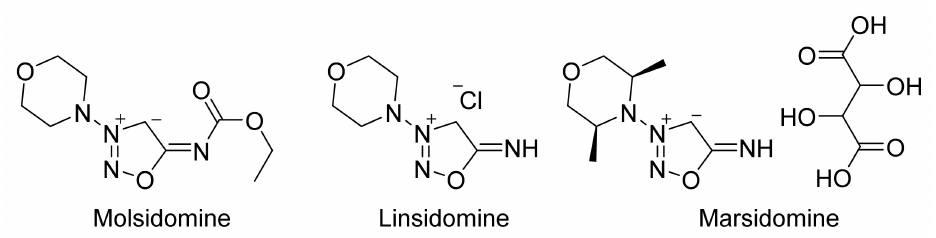
Figure 2. Structures of sydnone imine-based